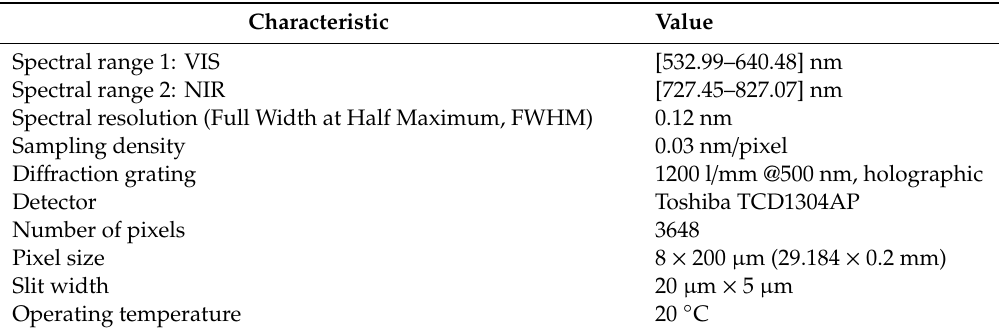
Table 1. Developed spectrometer main